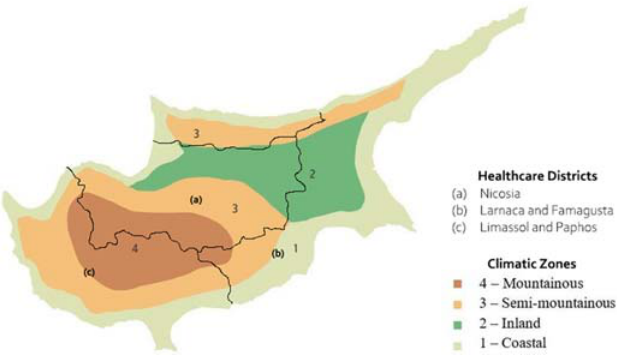
Fig. 1. Map representing the three healthcare districts of Cyprus and the climatic zones